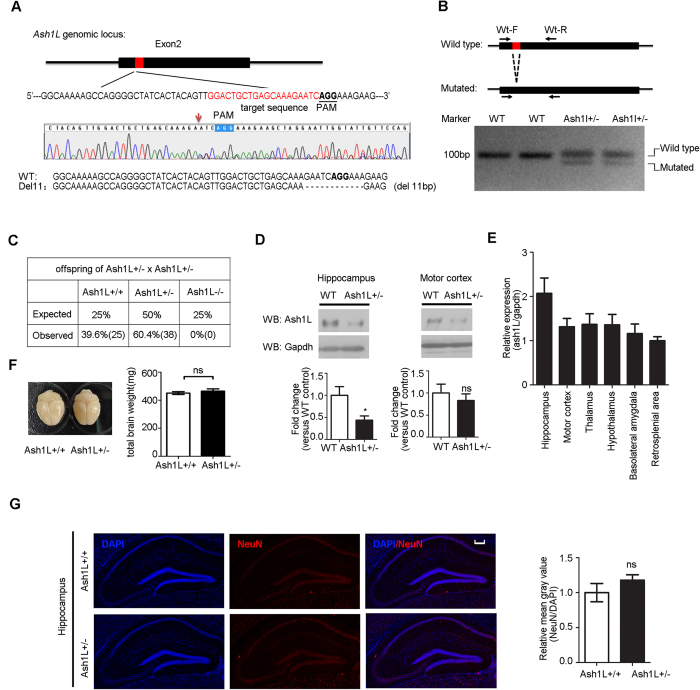
The generation of the Ash1L mutant mice.(A) CRISPR/Cas9-mediated mutation in the Ash1L locus. The top panel shows a schematic diagram of exon 2. The location of the targeted sequence is indicated in red with the corresponding PAM underlined. An indel mutation at the target locus revealed by DNA sequencing is shown in the middle panel. T-A cloning and DNA sequencing showed a targeted 11 bp deletion, which is indicated by a hyphen on the bottom panel. (B) A primer pair of Ash1L-Mt-F/R was used to distinguish between the wild-type allele and the 11 deletion allele (full-length gels in Fig. S5). (C) Genotyping of litters from Ash1L (−/+) intercrosses. (D) Western blot analysis of Ash1L in the hippocampus, motor cortex, in 3-month-old WT mice and Ash1L (−/+) mice (full-length blots and hypothalamus and thalamus in Fig. S5; n = 6 for WT mice, n = 9 for Ash1L (−/+) mice; Student’s t-test, *P < 0.05). (E) Ash1L expression in brain regions of 3-month-old WT mice. The amount of Ash1L mRNA were quantified by q-PCR relative to GAPDH. Data are presented as the amount relative to the retrosplenial area (n = 5). (F,G) Ash1L (−/+) mice aged 3 months showed normal brain weights (F) (n = 12 for WT mice; n = 13 for Ash1L (−/+) mice) and neuron density in the hippocampus (G) (n = 3 for WT mice; n = 4 for Ash1L (−/+) mice; blue, DAPI; red, NeuN). Student’s t-test, *P < 0.05, ns, no significance. Scale bar = 200 μm.